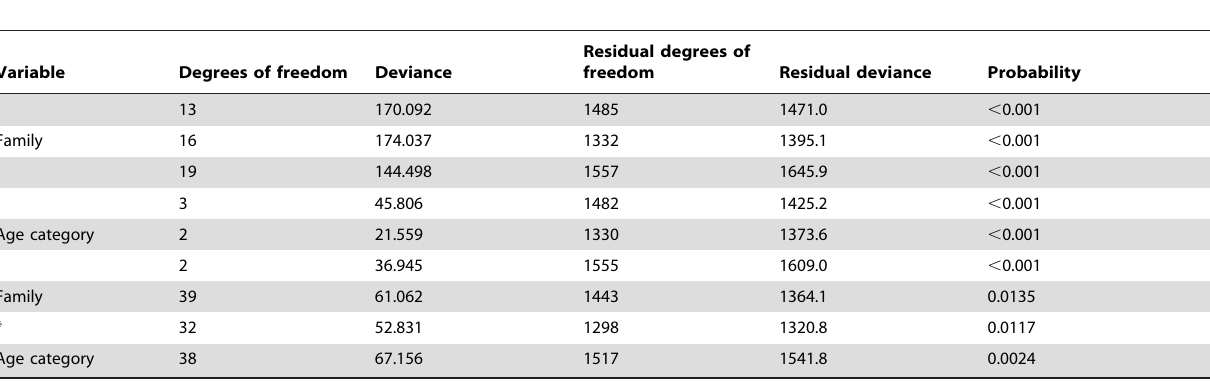
Table 1. Generalised linear model (binomial errors, logit link) of the effect of sample taxonomic affiliation and sample age over PCR